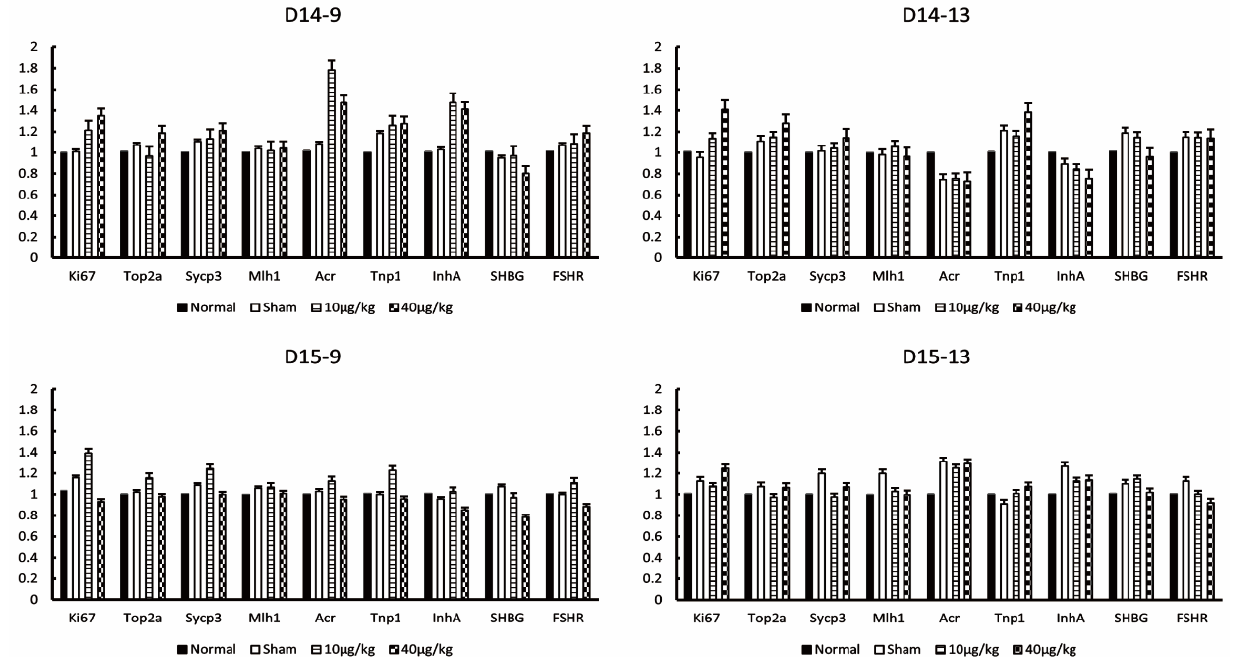
Figure 5. Effects of DEX administration on germ cells and Sertoli cells. The expression levels of Ki67, TOP2a (topoisomerase 2-alpha), Sycp3 (synaptonemal complex protein 3), Mlh1 (MutL homolog 1), Acr (acrosin), Tnp1 (transition protein 1), InhA (Inhibin-A), SHBG (sex-hormone-binding globulin), and FSHR (follicle-stimulating hormone receptor) at each testis collection point were measured by RT-PCR. The values of graph are presented as the means ± SDs. The sampling points after 14 days continuous DEX administration from mice were 9:00 on day 14 (D14-9), 13:00 on day 14 (D14-13), 9:00 on day 15 (D15-9), and 13:00 on day 15 (D15-13).